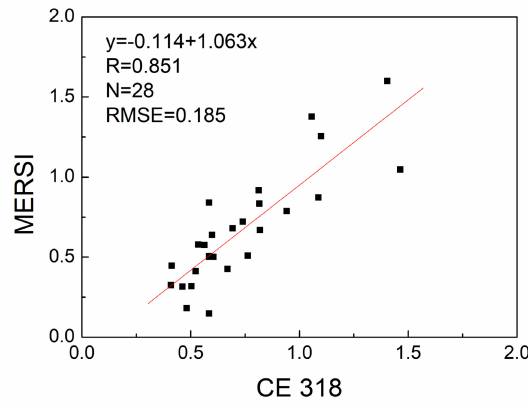
Figure 14. Scatter plot of MERSI and CE318 AODs. Table 3. Validation of AODs with CE318 AODs Total in